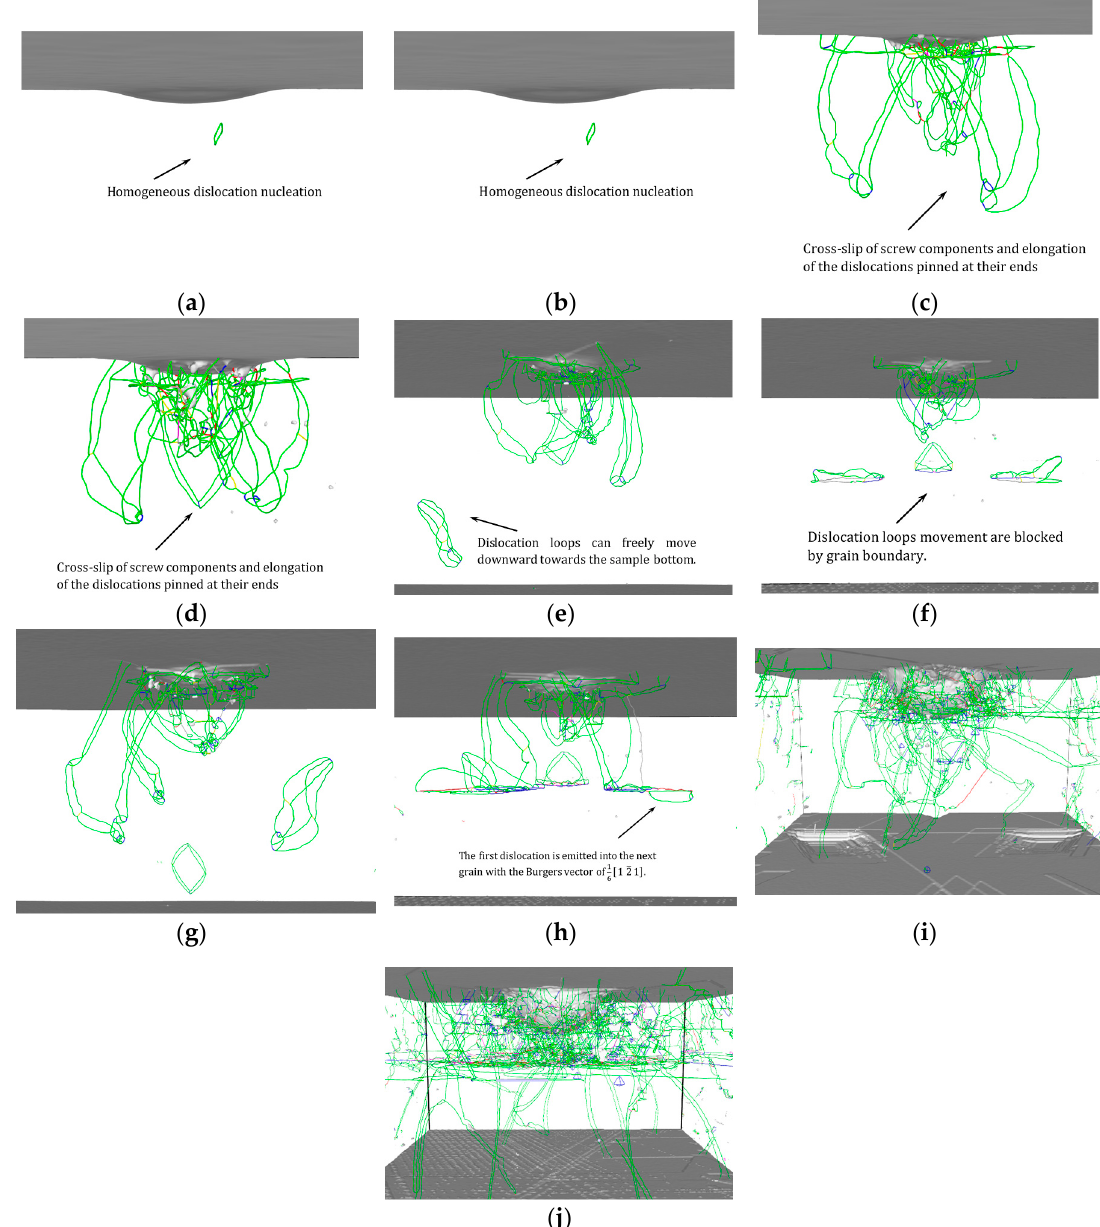
Figure 22. Effect of ∑ 3 ( 1 1 1 ) 1 1 0 GB on the dislocation nucleation and evolution of large sample at different indentation depths: ( a ) single crystal sample, ℎ ≈ 0.88 nm ; ( b ) bicrystal sample, ℎ ≈ 0.88 nm ; ( c ) single crystal sample, ℎ ≈ 1.15 nm ; ( d ) bicrystal sample, ℎ ≈ 1.15 nm ; ( e ) single crystal sample, ℎ ≈ 1.44 nm ; ( f ) bicrystal sample, ℎ ≈ 1.44 nm ; ( g ) single crystal sample, ℎ ≈ 2.03 nm ;